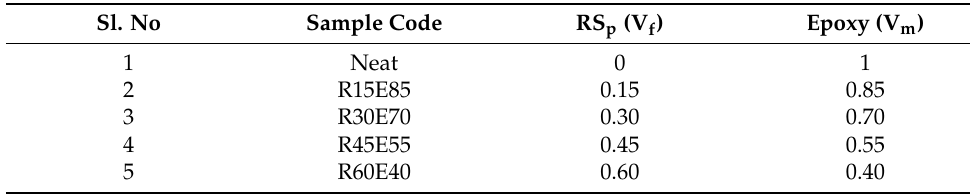
Table 2. Composition and coding of test samples.